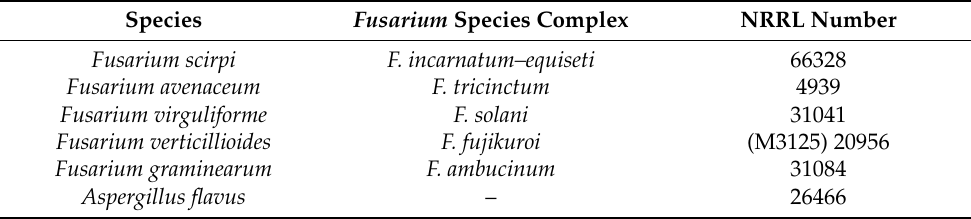
Table 1. Culture isolates utilized in this